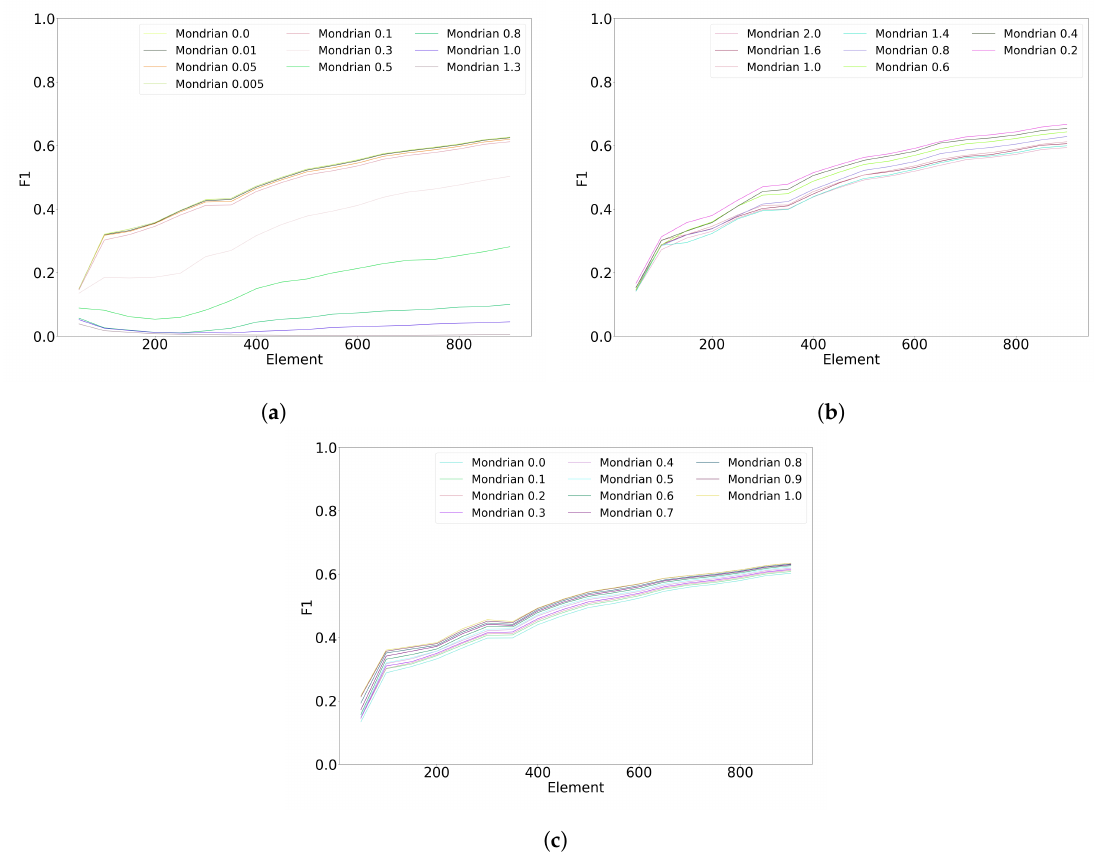
Figure 5. Hyperparameters tuning for Mondrian with the first subject of Banos et al. dataset. ( a ) Impact of the base count with 10 trees, a budget of 1.0, and a discount factor of 0.2. ( b ) Impact of the budget with 10 trees, a base count of 0.1, and discount factor of 0.2. ( c ) Impact of the discount factor with 10 trees, a budget of 1.0, and a base count of